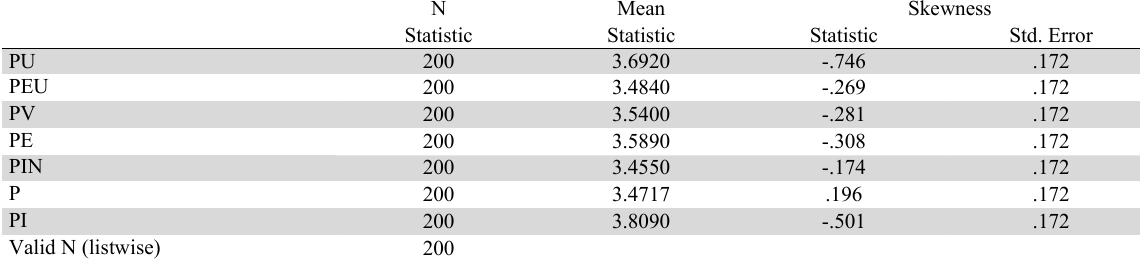
Showing Descriptive Statistics showing Skewness N Mean Skewness Statistic Statistic Statistic Std. Error